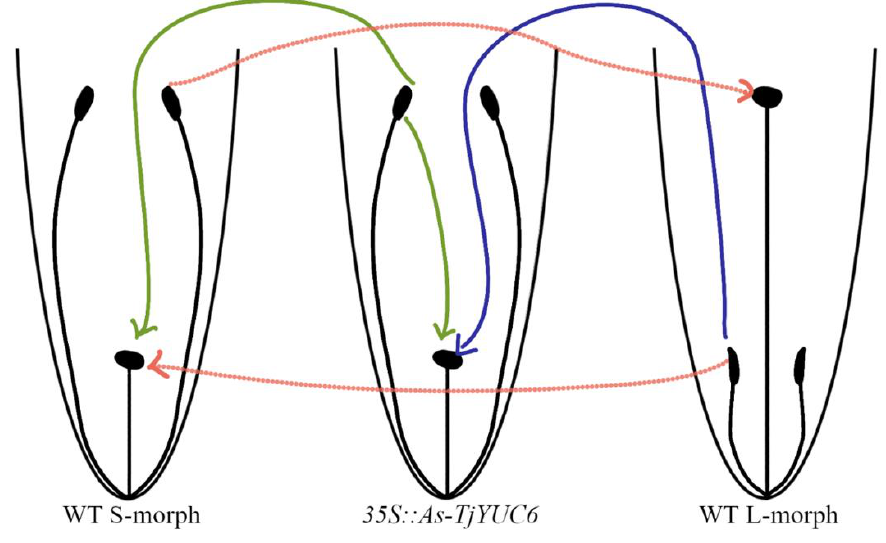
Figure 1. Model of the most extreme observed change in male mating type but retention of female mating type in the knockdown TjYUC6 lines. Green lines represent successful pollination from the transgenic lines with self and WT lines. Blue line represents successful pollinations from the WT lines with transgenic lines. Dotted red lines represent WT pollinations.